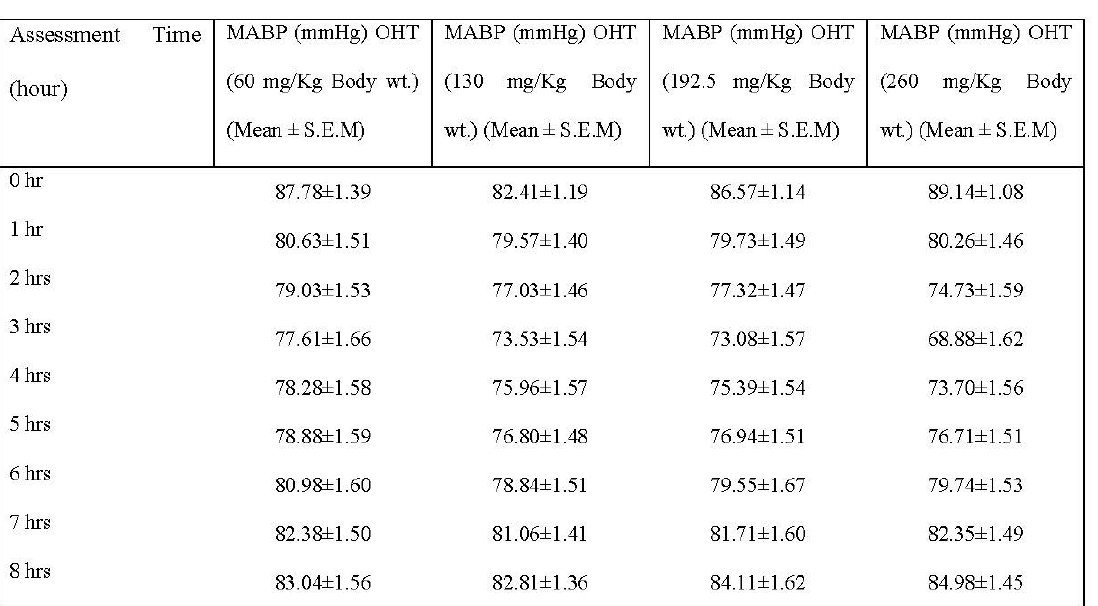
Figure 3 : The response of IOP to CSAE was dose dependent. The higher the dose of CSAE administered, the greater the fall in the percentage mean IOP in normotensives (NT) and ocular hypertensives (OHT) right eye. Table 1 : MABP across the different time of assessment after administering CSAE compared to water (control) in ocular hypertensive subjects